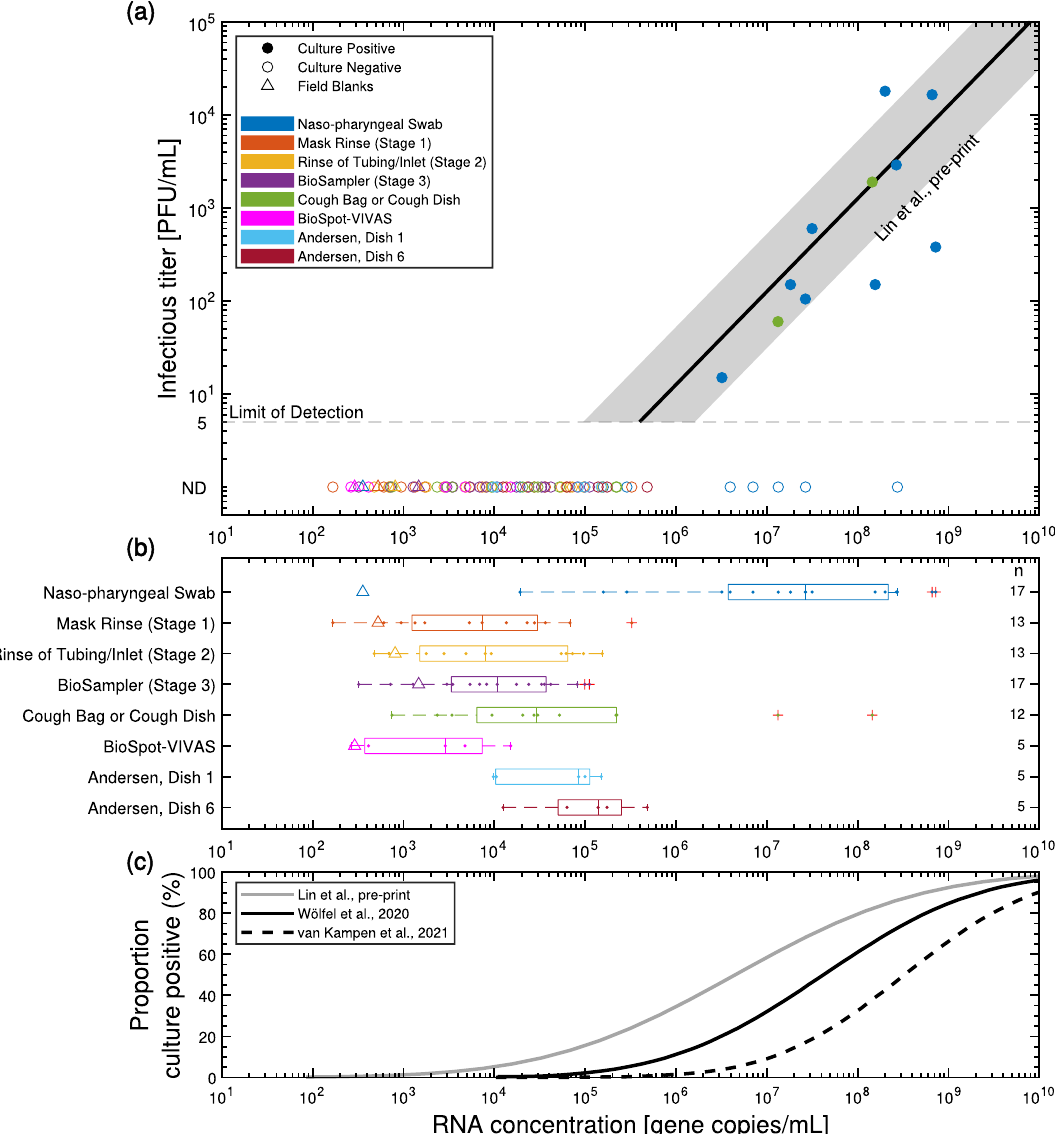
Figure 1. ( a ) Infectious titer determined by viral culturing using plaque assay as a function of gene copies of SARS-CoV-2 RNA (N gene) per mL of sample (comprising viral transport media and respiratory tract fluid) determined by RT-qPCR. Solid or hollow circles were positive or negative by viral culture, respectively (limit of detection: 5 PFU/mL). The dark gray line represents the mean ratio of infectious titer/mL to gene copies/mL for a range of samples using the same viral culture and RT-qPCR methods as in this study 42 . The shaded region shows the 95% confidence interval. ( b ) Gene copies/mL for each sample type as a standard box-and-whisker plot and including all participants in this study. One set of field blanks (denoted by triangles) was gathered from a hospital inpatient not infected with SARS-CoV-2. The small markers depict the results of each individual sample. ( c ) Fraction of samples which showed positive viral culture as a function of gene copies/mL using data from Lin et al. 42 (33% positive by viral culture) and reproduced from Wölfel et al. 43 for mostly sputum samples and van Kampen et al. 44 for samples from the respiratory